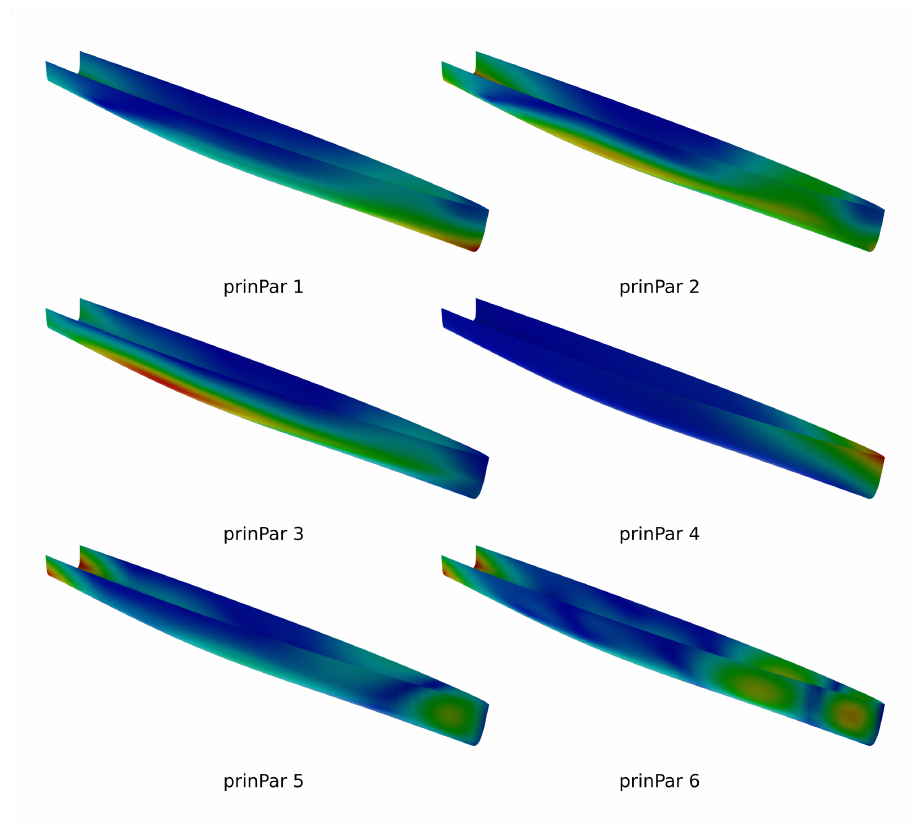
Figure 10. Influence of first six principal parameters (prinPar) on the hull